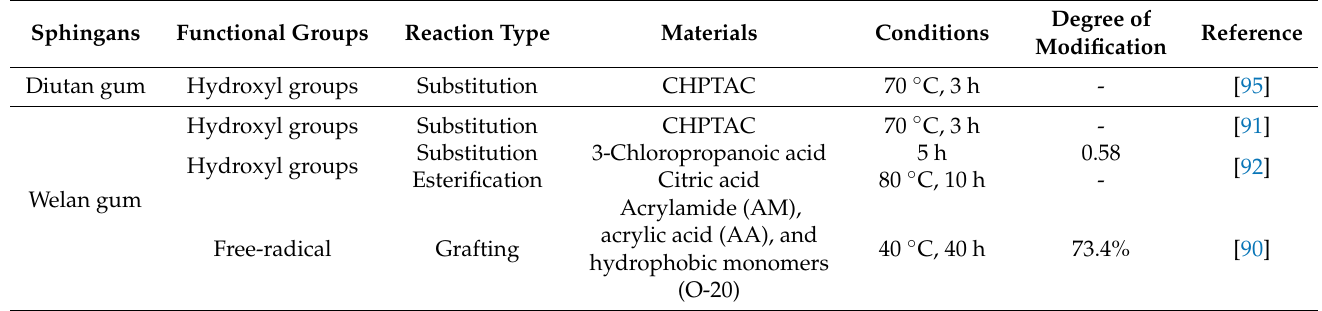
Table 4. Chemical modification methods and their